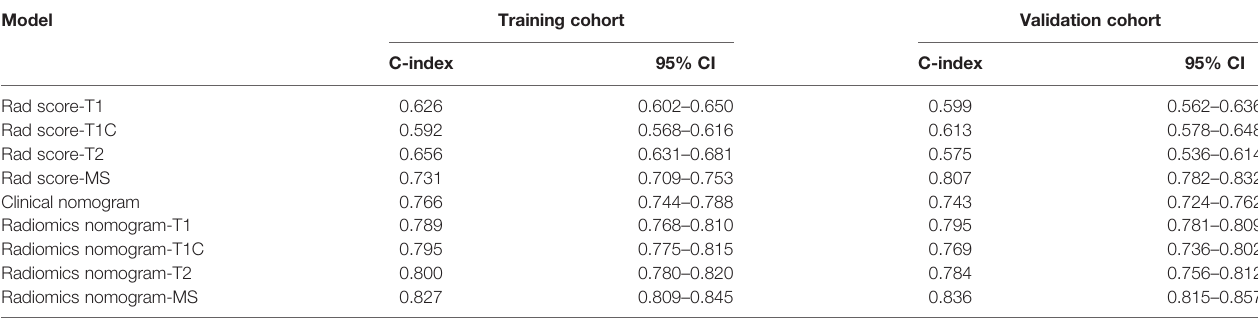
TABLE 2 | Comparison of the discriminating performance of the Rad score clinical nomogram and radiomics nomograms built by incorporating clinical risk factors and Rad score calculated from different MRI sequences.